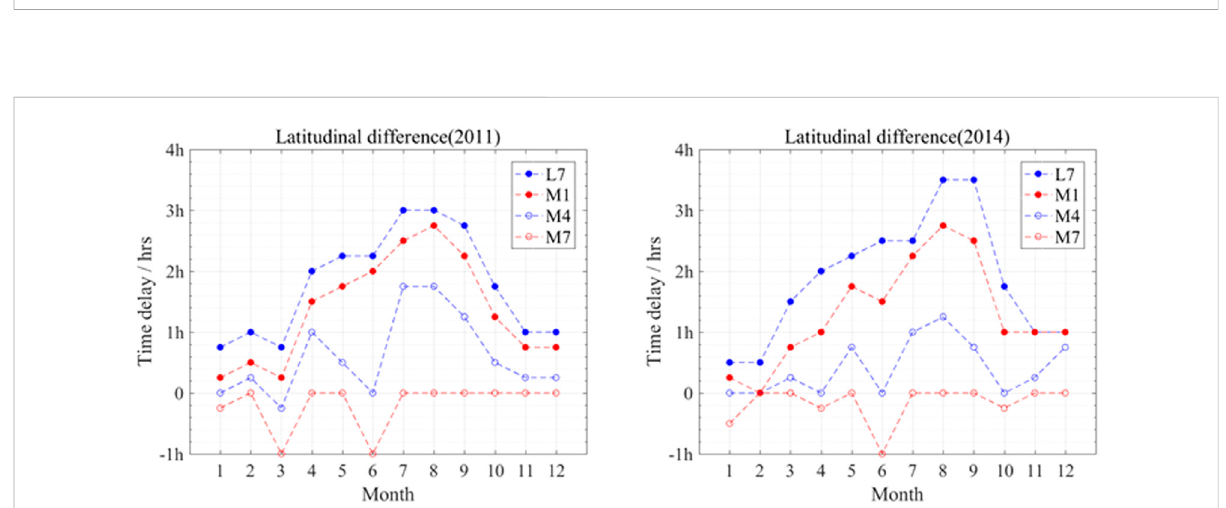
FIGURE 7 Comparison between stations at similar longitudes but different